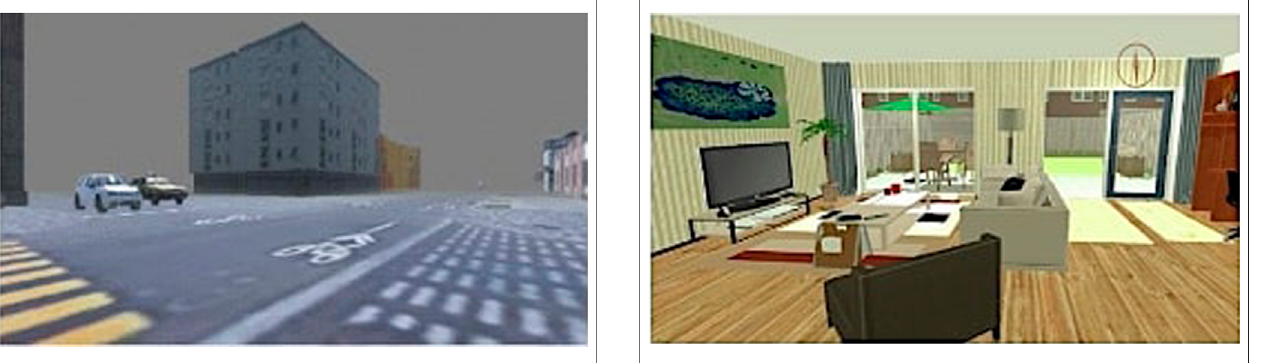
FIGURE 7 | Sobhani et al. (2017) excluded other pedestrians and cyclists, focusing on vehicles and the participant.